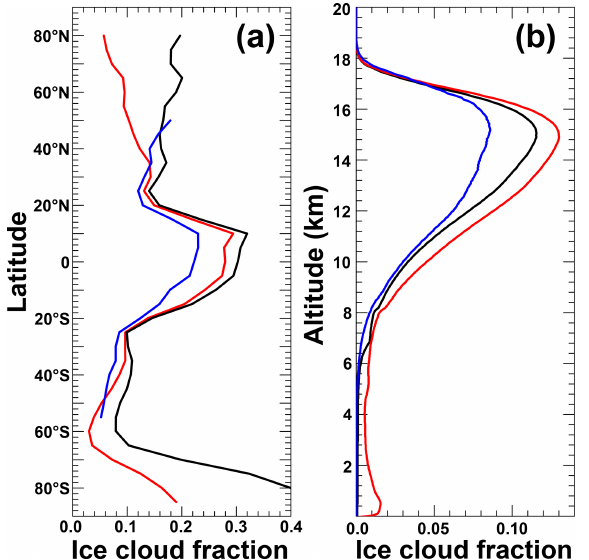
Figure A2. (a) Latitudinal distribution and (b) height profiles of the cloud fractions of isolated cirrus as seen by CALIPSO (black) and of isolated ice clouds as seen by CALIPSO (red) and CATS (blue) for the time period from March 2015 to October 2017.